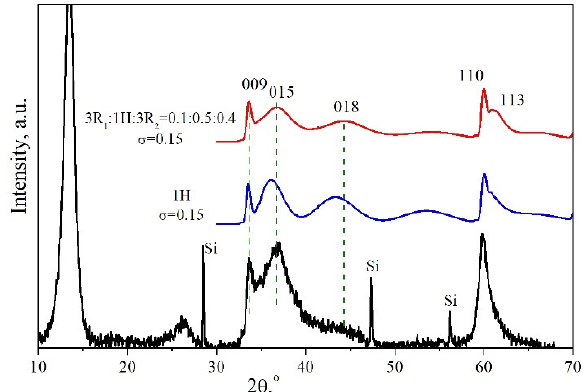
Figure 4. Simulation of XRD patterns for the dehydrated MgGa LDH phase (T = 200 °C).